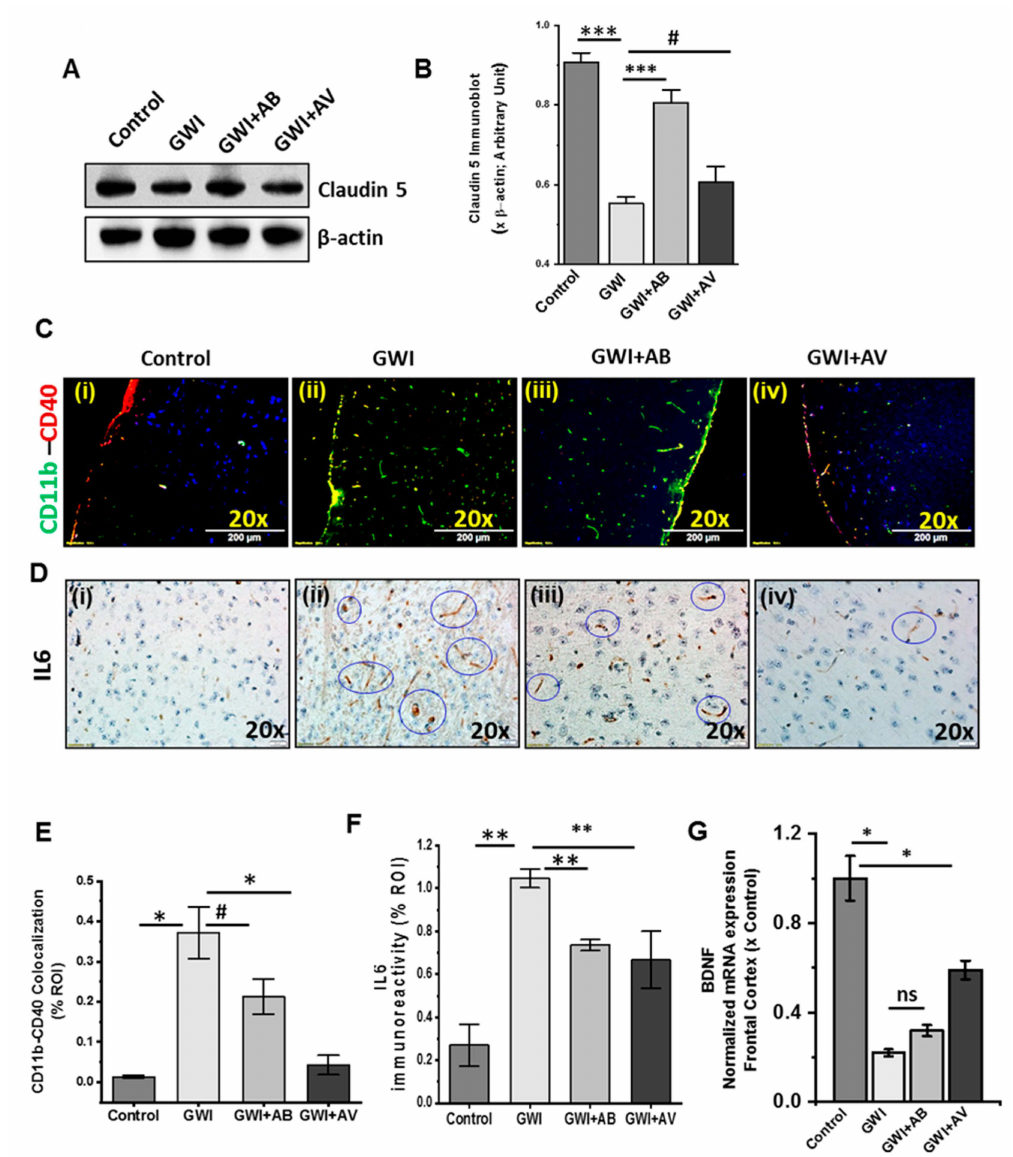
Figure 8. Anti-viral or antibiotic intervention improves neuroinflammation in GWI. ( A ) Western blot analysis of Claudin-5 and β -actin protein in the frontal cortex of Control, GWI (Gulf war chemical exposed mice), GWI + AB (Gulf War chemical and antibiotic-treated mice), and GWI + AV (Gulf War Chemical and antiviral-treated mice). ( B ) Morphometry analysis of Claudin-5 immunoblot ( n = 5) normalized against β -actin were plotted as a bar graph. ( C ) Representative immunofluorescence images of frontal cortex showed CD40 (red) and CD11b (green) immunoreactivity and colocalization (yellow, marked with the arrows) in Control, GWI, GWI + AB, and GWI + AV mice. All sections were counterstained with DAPI (blue) and 3–15 images were taken from the di ff erent microscopic field of each group at 20X magnification. ( D ) Immunohistochemistry images for IL6 expression in the frontal cortex of Control, GWI, GWI + AB, GWI + AV. The prominent immunoreactivities were marked with the blue circles. ( E ) The morphometric analysis of colocalized area (yellow, calculated as % ROI) of CD11b-CD40 was plotted as a bar graph. ( F ) Morphometric analysis of IL6 immunohistochemistry images ( n = 3–15) calculated at % ROI. ( G ) mRNA expression of BDNF in mouse frontal cortex of Control, GWI, GWI + AB, and GWI + AV. The RT-PCR data were normalized against internal control 18S and plotted as fold-change to the control. Data points were represented with means ± SEM. Statistical significance was calculated using unpaired t -test; # p < 0.10, * p < 0.05, ** p < 0.01, *** p < 0.001. ns = non-significant at p ≥